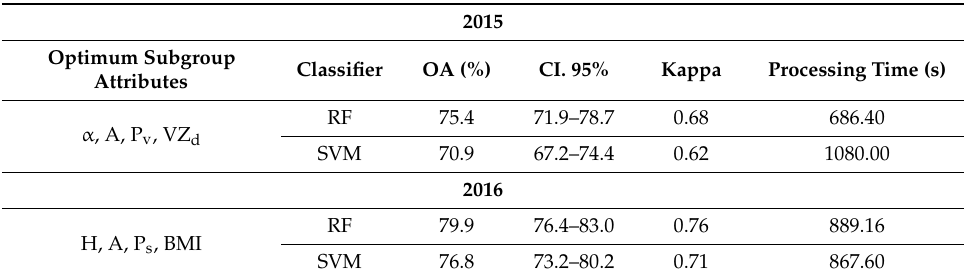
Table 5. Performance of the optimum subgroup of attributes in Random Forest (RF) and Support Vector Machine (SVM) classifiers. Attribute identification: H (entropy), α (alpha angle), and A (anisotropy) from Cloude–Pottier; P v (volumetric scattering), and P s (surface scattering) from Freeman–Durden; VZ d (double-bounce scattering) from van Zyl, and BMI (Biomass Index) from Pope indexes. Details of the SAR derived attributes are presented in Table 3.